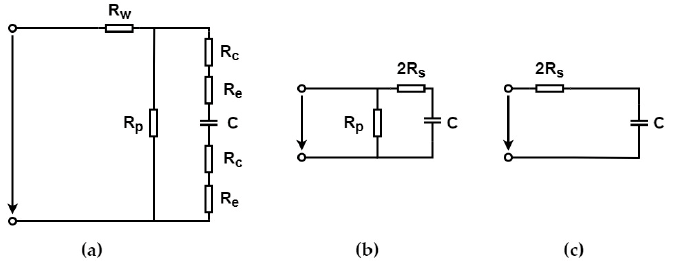
Figure 2. Electrical equivalent circuit of a DEA ( a ) all resistance in one layer included ( b ) resistance of the supply line neglected and combined connection and electrode resistance ( c ) resistance of the elastomer neglected.